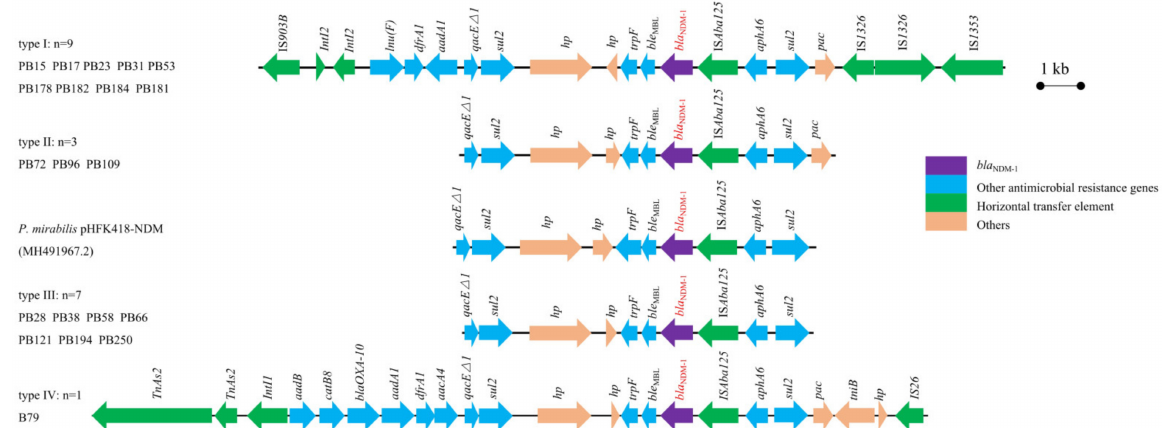
Figure 6. Comparison of different genetic environments of carrying bla NDM-1 P. mirabilis . Arrows indicate the directions of transcription of the genes, and different genes are shown in different colors. The shaded grey areas indicate nucleotide identity (>99.0%) with the same or inverted